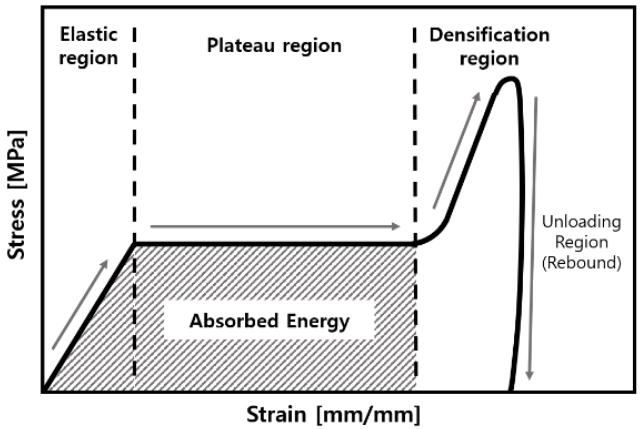
Figure 13. Stress–strain curve based on the results of the impact test. Figure 13. Stress – strain curve based on the results of the impact test.